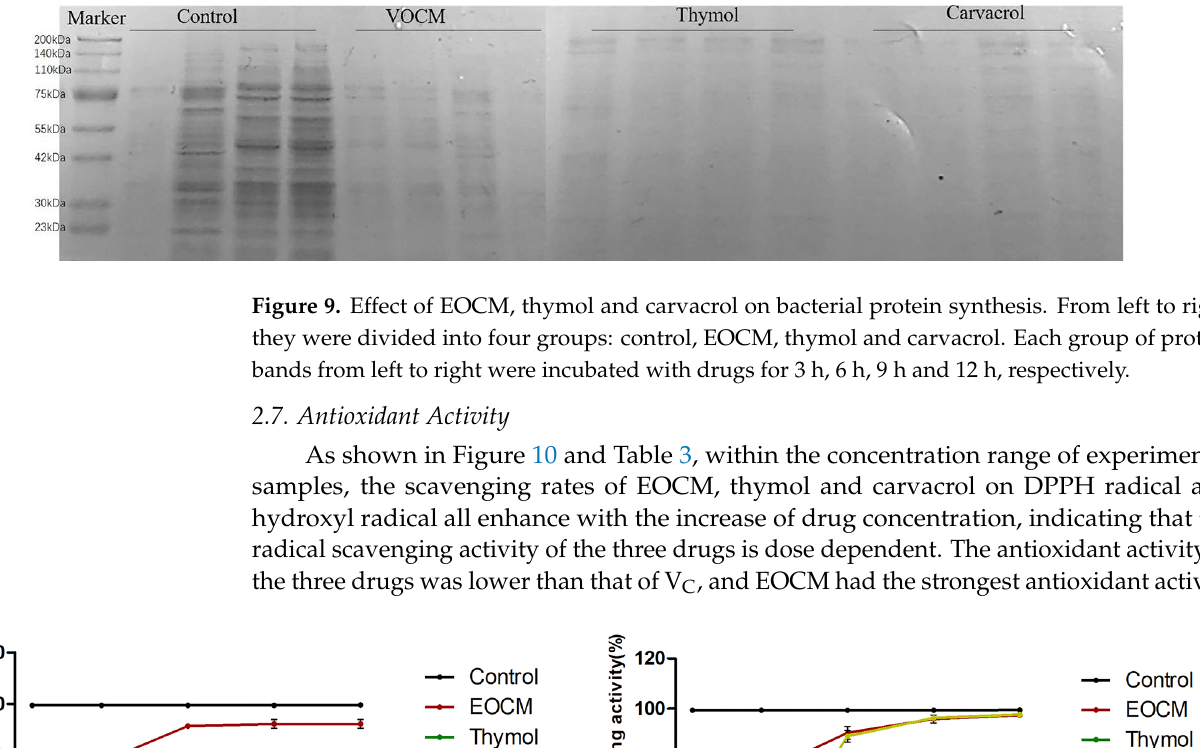
9 of 15 Figure 8. Effect of EOCM, thymol and carvacrol the growth of S. aureus biofilm under CLSM. 2.6. SDS-PAGE Electrophoresis of the Bacterial Proteins Protein is the material basis of all life, which can maintain the normal metabolism and transportation of various substances in the body, and the enzymes that play a catalytic role in various biochemical reactions in cells and organisms are mainly proteins, so the